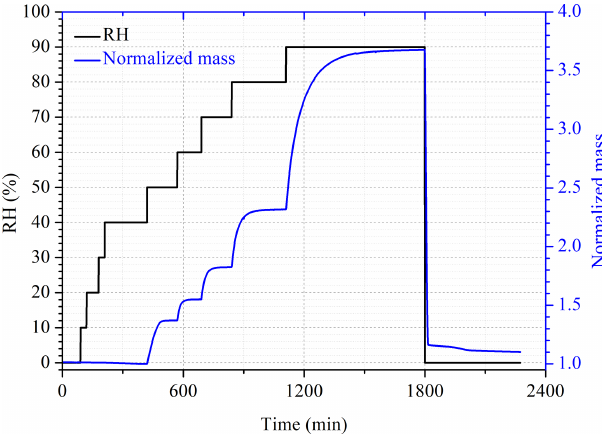
Figure 2. Change in RH (black curve, left y axis) and normalized sample mass (blue curve, right y axis) of CH 3 SO 4 Na with of time in a typical vapor sorption analyzer experiment at 25 ◦